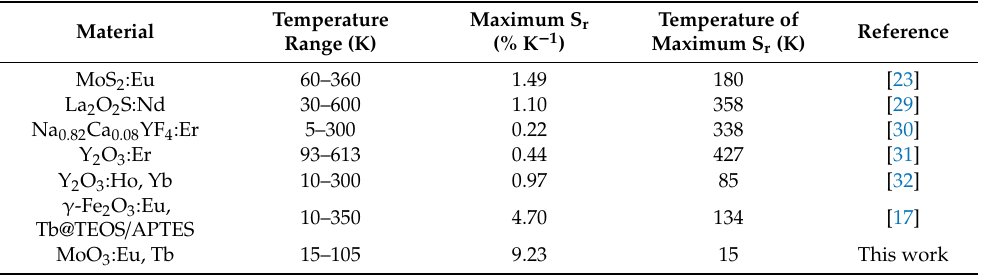
Tb 3+ materials showed good repeatability (R = 92%).